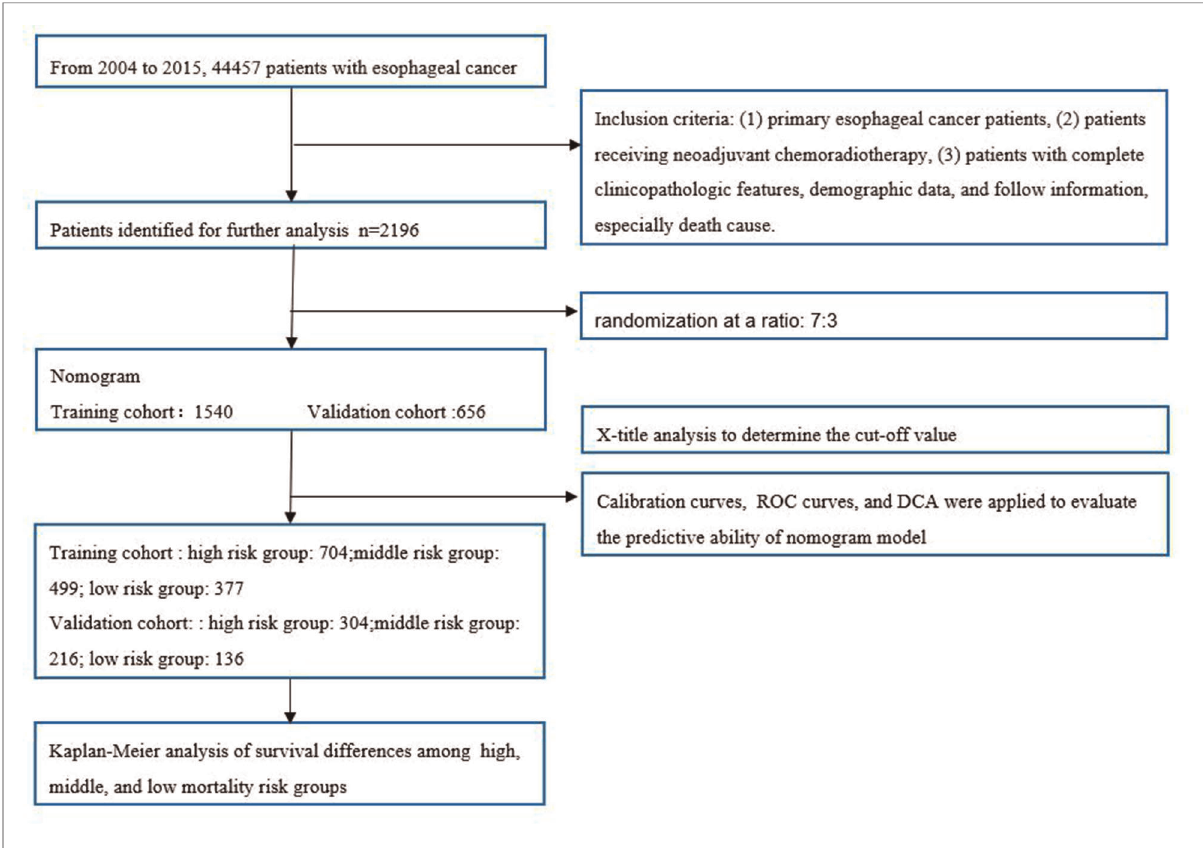
FIGURE 1 The fl ow chart of patient selection and data